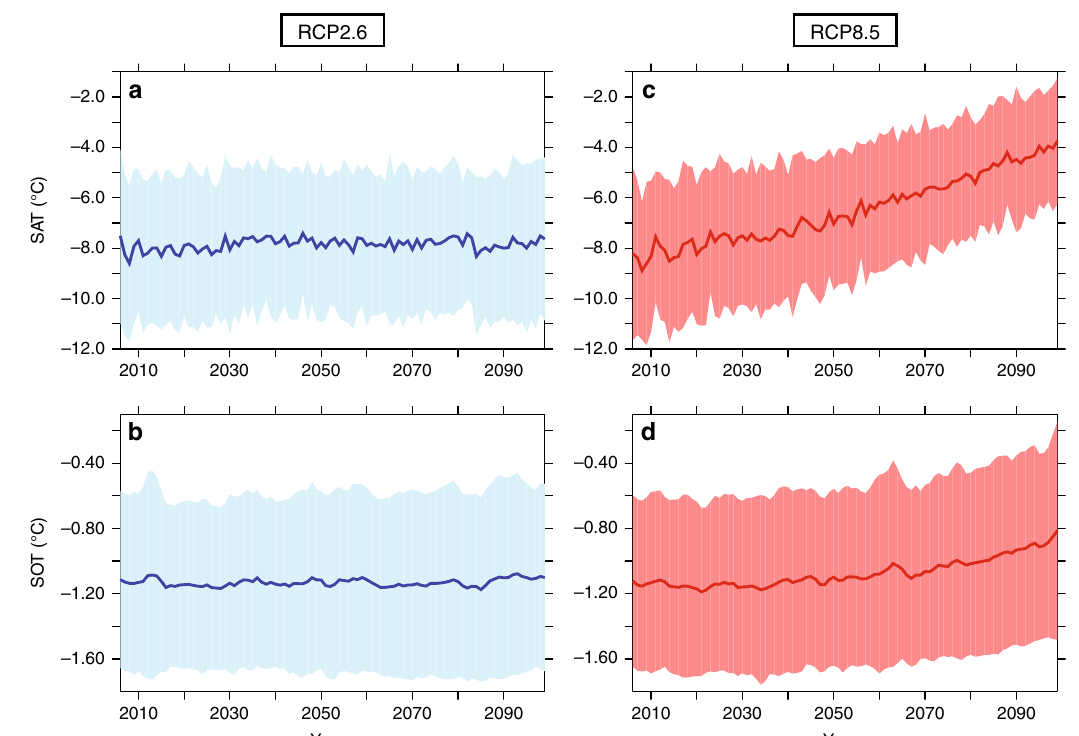
Fig. 4 SAT and SOT projections from the present to 2100. Mean SAT and SOT (°C) simulations based on the a , b RCP2.6 and c , d RCP 8.5 scenarios 47 using 26 CMIP models along the EAP margin. The thick lines represent the ensemble mean. The overlaps correspond to one standard deviation of the